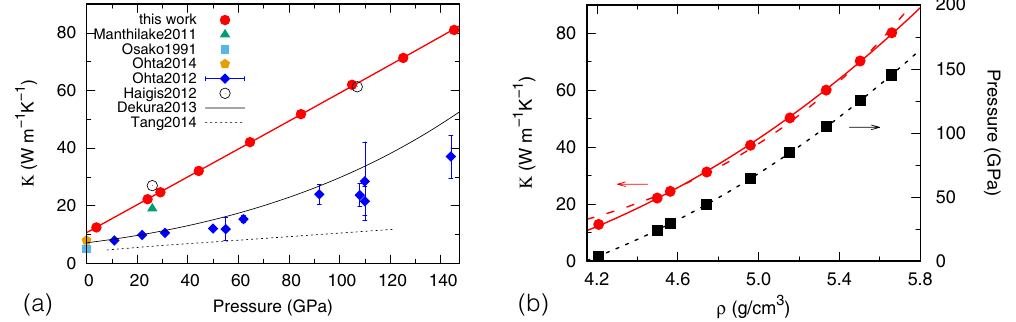
Figure 1. Lattice thermal conductivity of MgSiO 3 pv at 300 K as a function of ( a ) pressure ( b )